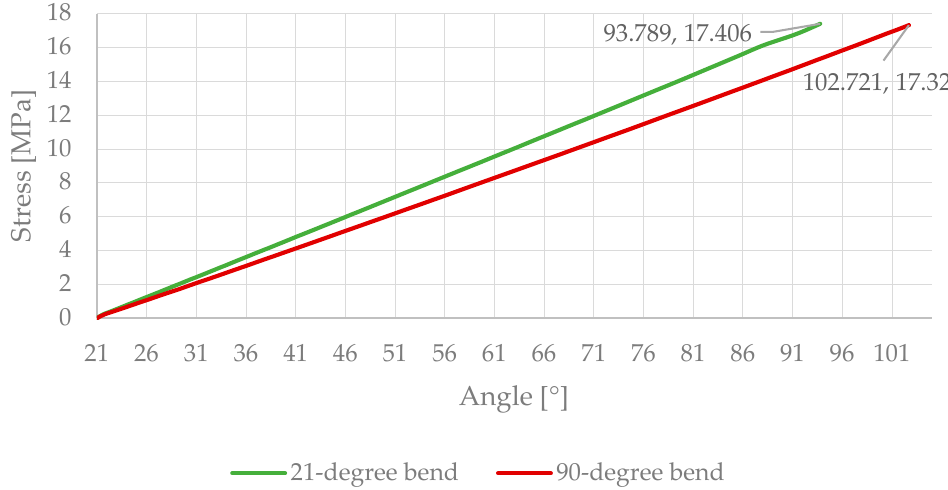
Figure 13. Stress–angle diagram for compliant fingers obtained by FEA.